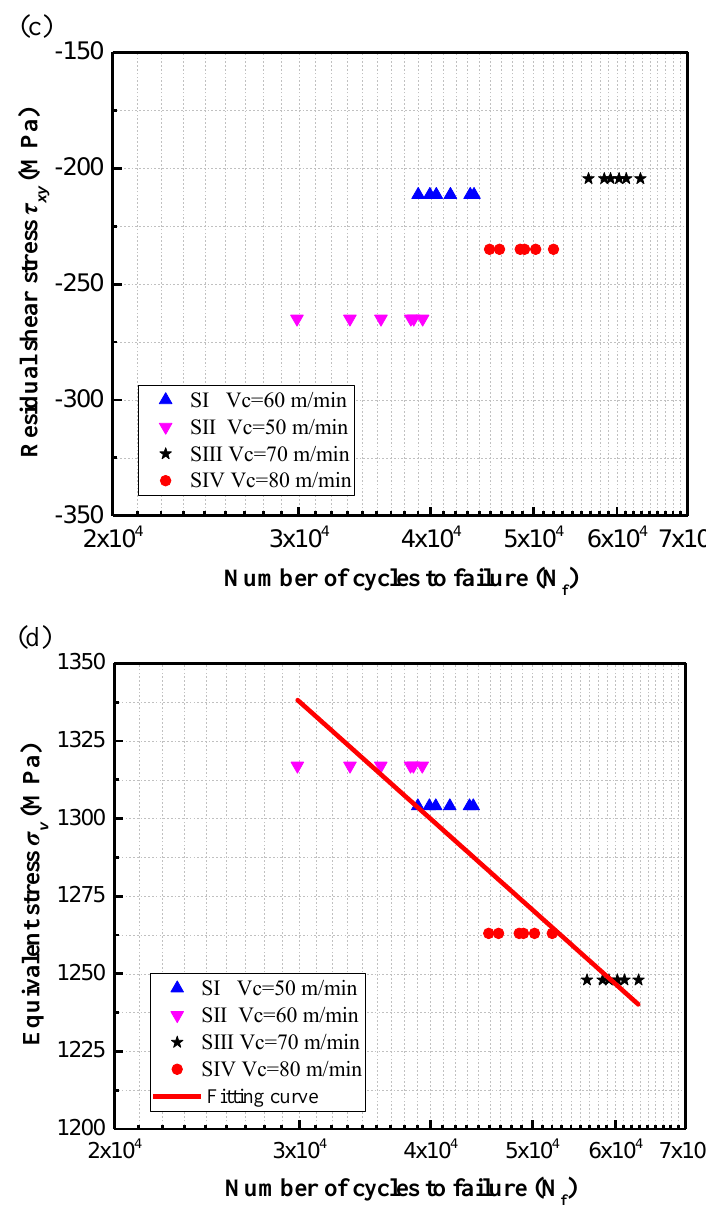
Figure 6. Fatigue life at different stresses: ( a ) residual normal stress σ xx , ( b ) residual normal stress σ yy , ( c ) residual shear stress τ xy , and ( d ) equivalent stress σ v.